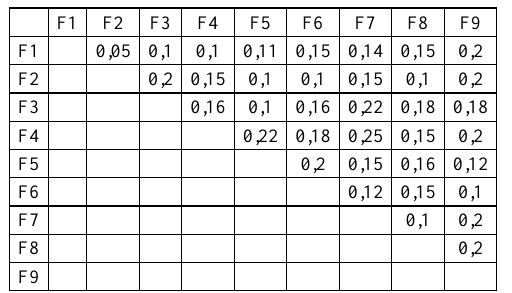
Table 3. Cost coefficients